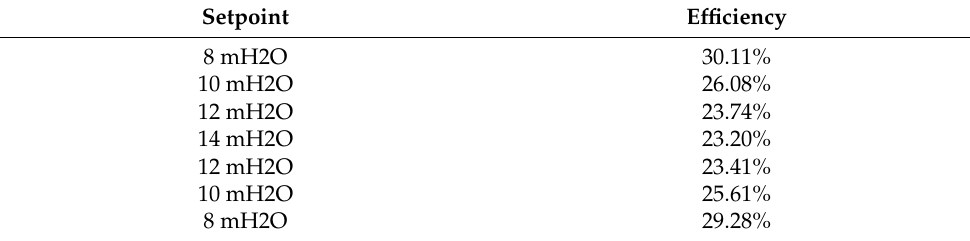
Table 4. Energy efficiency of the system with fuzzy control (MB 1). Setpoint